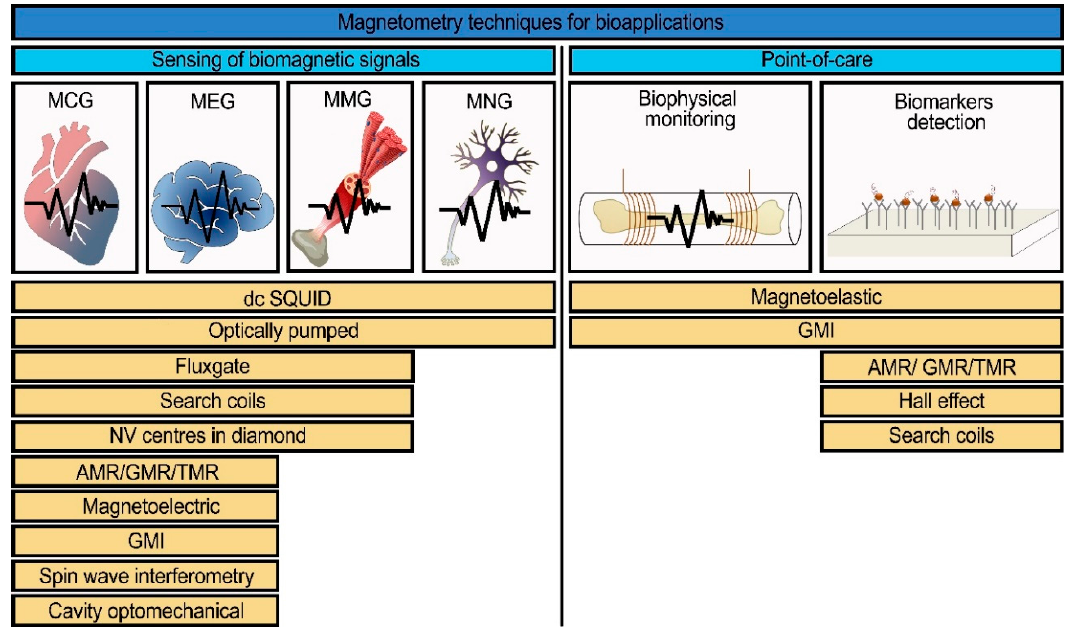
Figure 1. A list of the common and modern magnetic field sensors with the potential to be used for the detection of biomagnetic signals (magnetocardiography (MCG), magnetoencephalography (MEG), magnetomyography (MMG), magnetoneurography (MNG)) and for point-of-care devices [18–35].